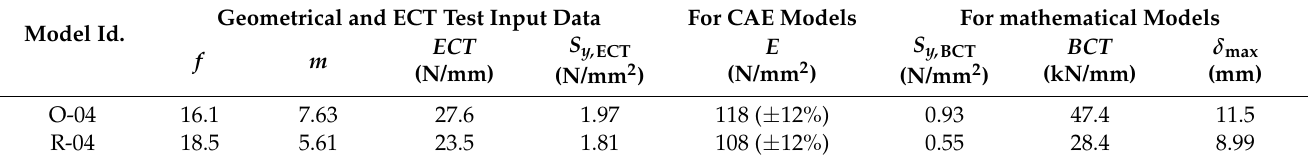
Table 5. Data for the finite element and mathematical models. Model